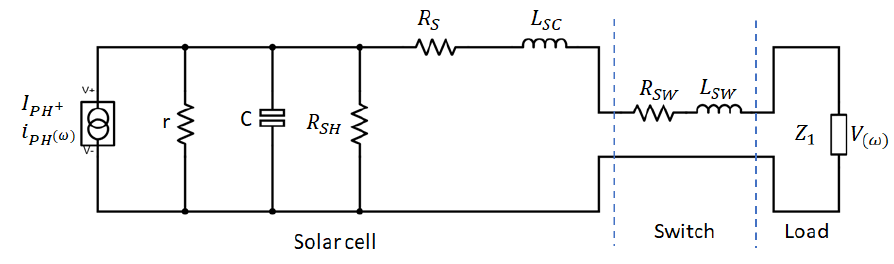
Figure 3. Time switching solar panel circuit